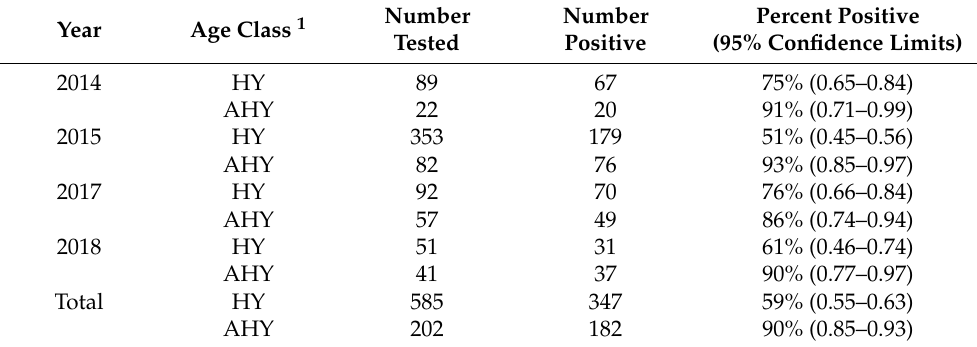
Table 1. Prevalence of antibodies to influenza A virus in sera collected from wild mallards in Northwest Minnesota, USA, by year and age